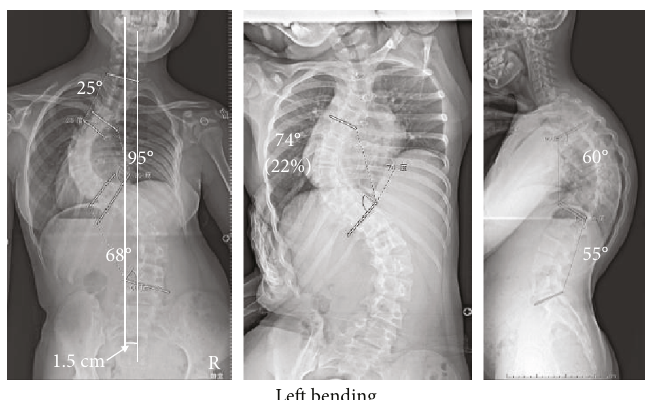
Figure 3: Case 2: preoperative radiographs (from left to right: anteroposterior, side-bending, lateral). Anteroposterior radiograph shows a major thoracic curve of 95 ° with a central sacral vertical line 1.5 cm to the left of the vertical plumb line. Side-bending radiograph shows